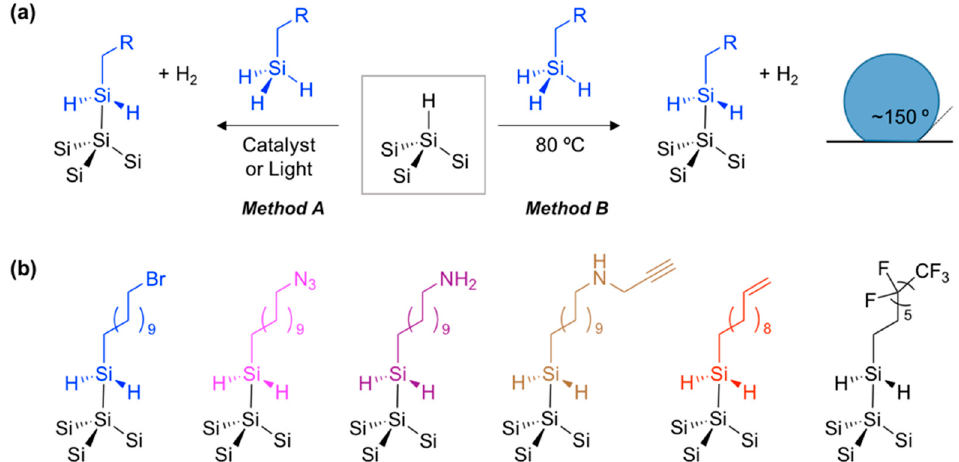
Figure 5. Thermally induced dehydrocoupling of the native pSi surface (Si–H) with trihydridosilane reagents (H 3 Si-CH 2 -R, marked in blue). ( a ) Dehydrocoupling by catalyst or light (Method A) and mild heat (Method B). Inset figure: water contact angle of reaction product. ( b ) Summary of reaction products of pSi with various trihydridosilane reagents.